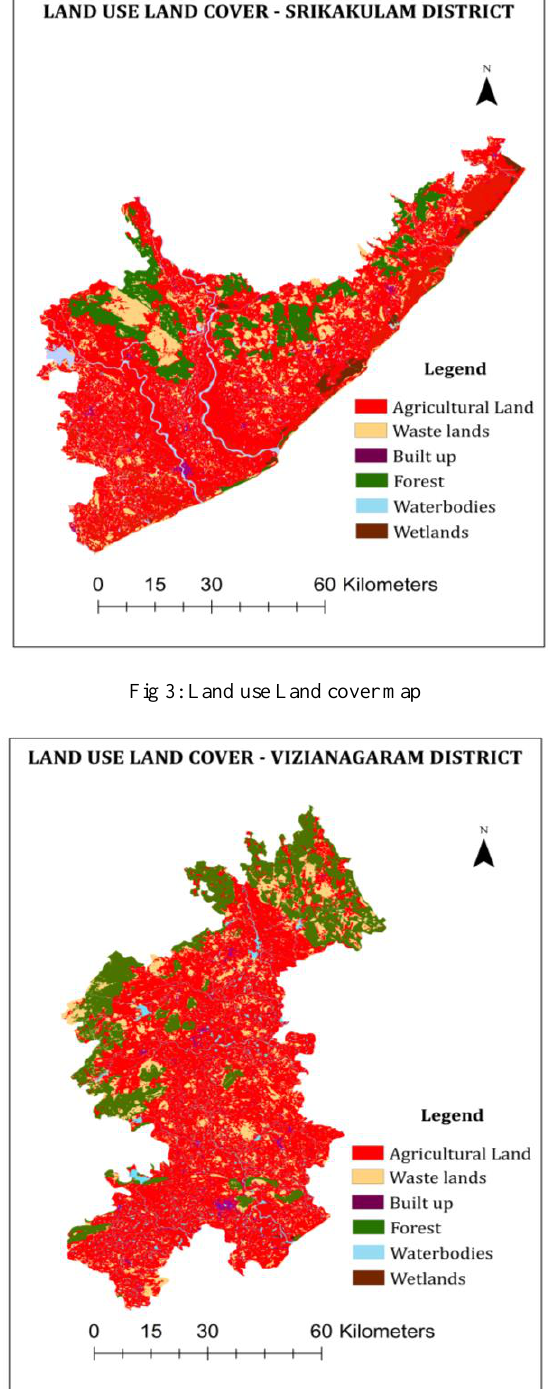
Fig 4: Land use Land cover